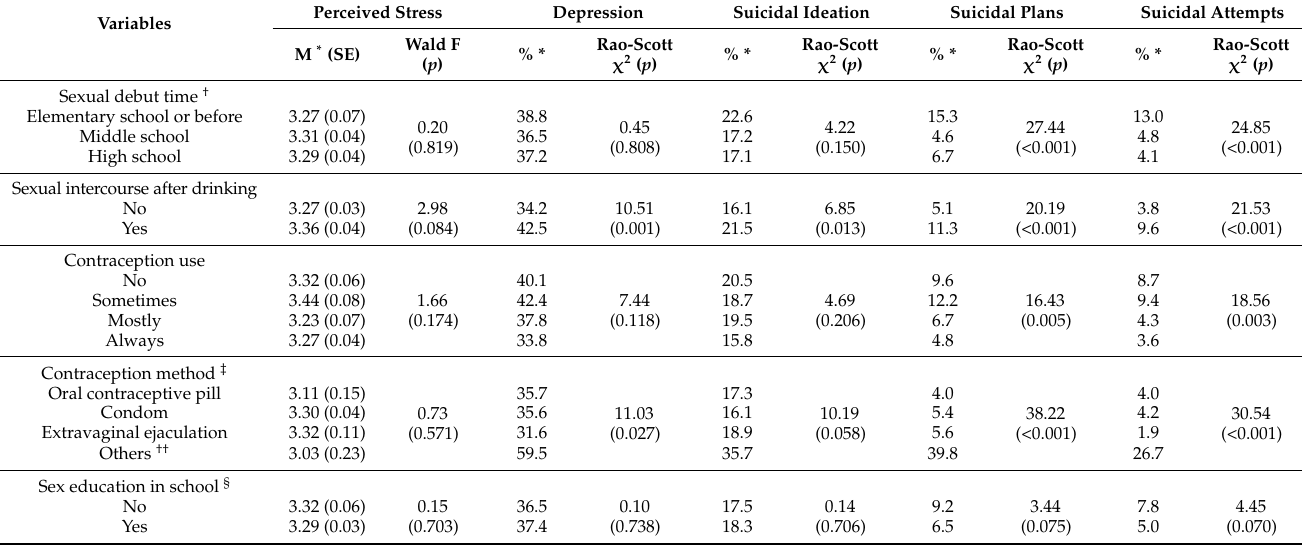
Table 2. Differences in mental health according to sexual behavior in boys ( n =